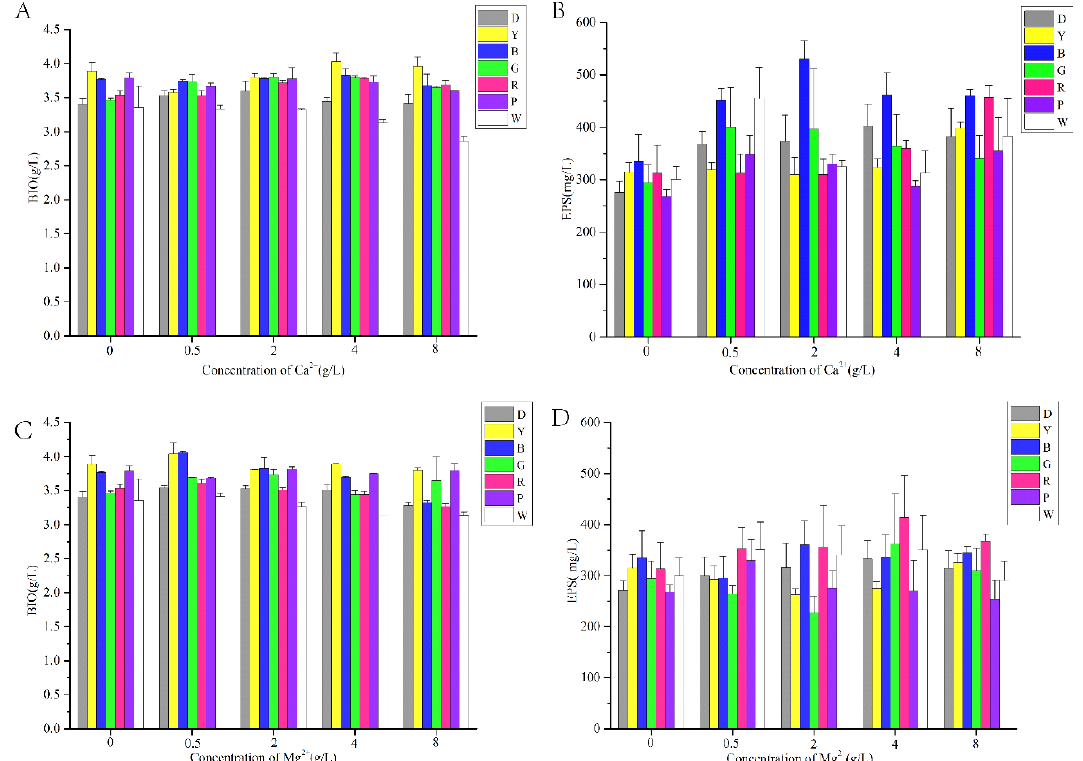
Figure 1. The effect of LED irradiation, including darkness (D), yellow (Y), blue (B), green (G), red (R), purple (P), and white (W) combined with metal ions on mycelial BIO (g/L) growth ( A , C ) and EPS production (mg/L). ( B , D ) A. sinodeliciosus var. Chaidam ZJU-TP-08. The concentrations of Ca 2+ and Mg 2+ were 0, 0.5, 2, 4, 8 g/L.